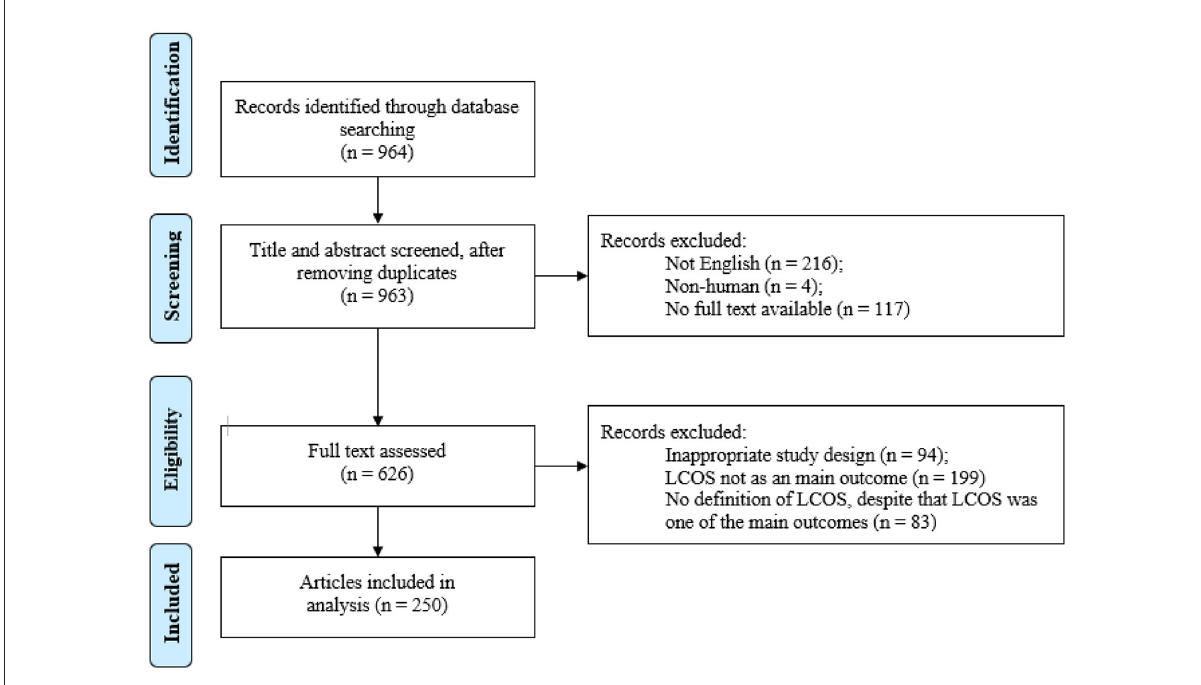
FIGURE1 Literature search. LCOS, low cardiac output